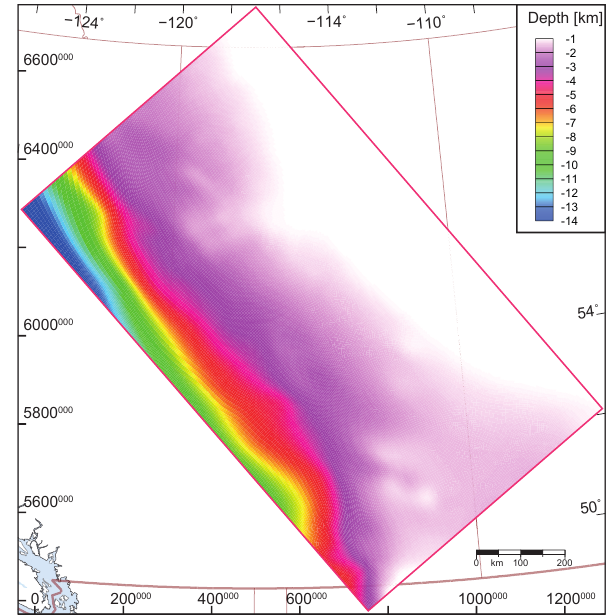
Figure 6. Topography of the basement top is shown within the model box. The map extent is indicated by geographical coordi- nates (top and right) and by UTM coordinates from zone 11 (left and